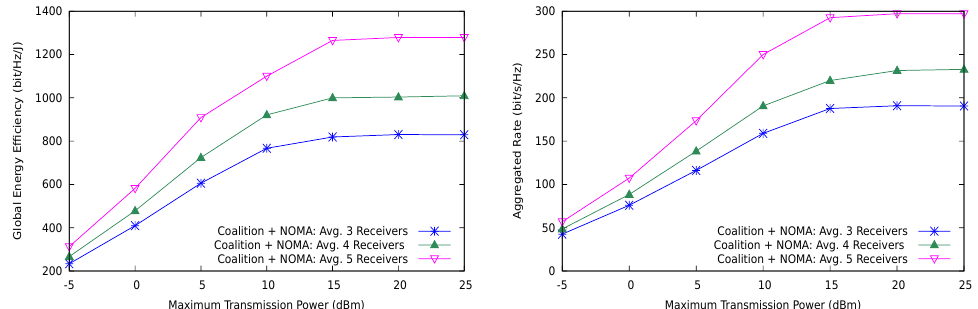
Figure 7. Global energy efficiency and aggregated rate with NOMA and the distributed coalition game for the general case with different group sizes.